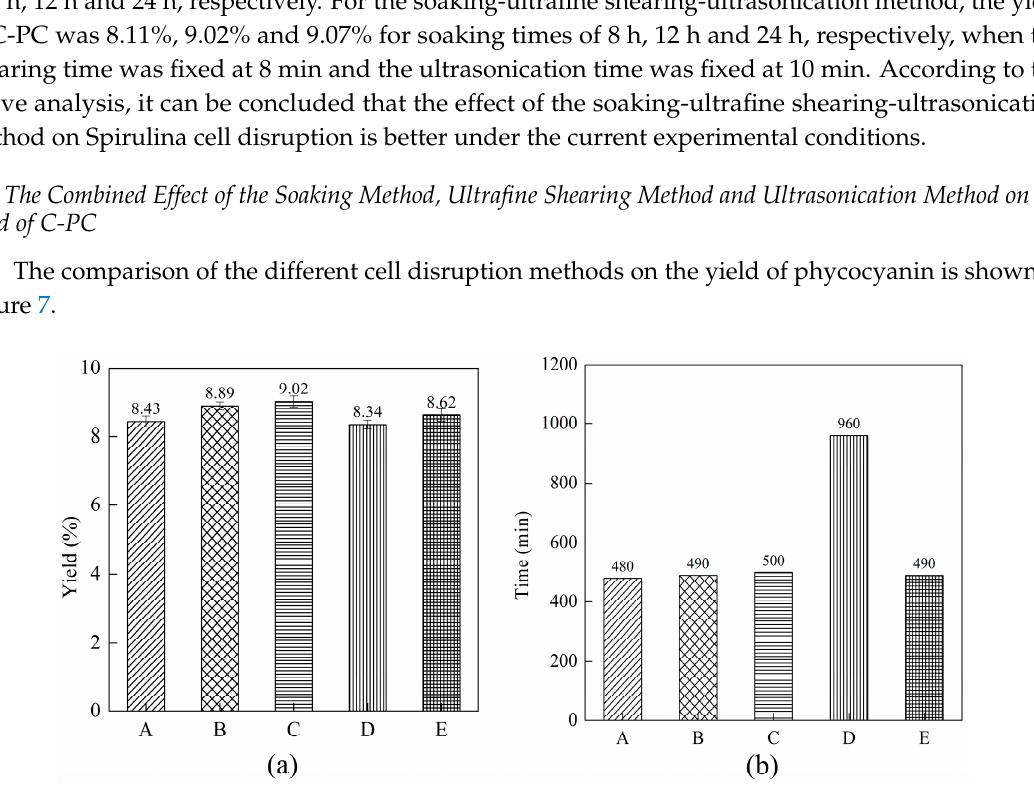
Figure 7. Comparison of the different cell disruption methods. Error bars indicate standard deviations of the means ( n = 3): ( a ) the yield of C-PC; ( b ) the extraction time.